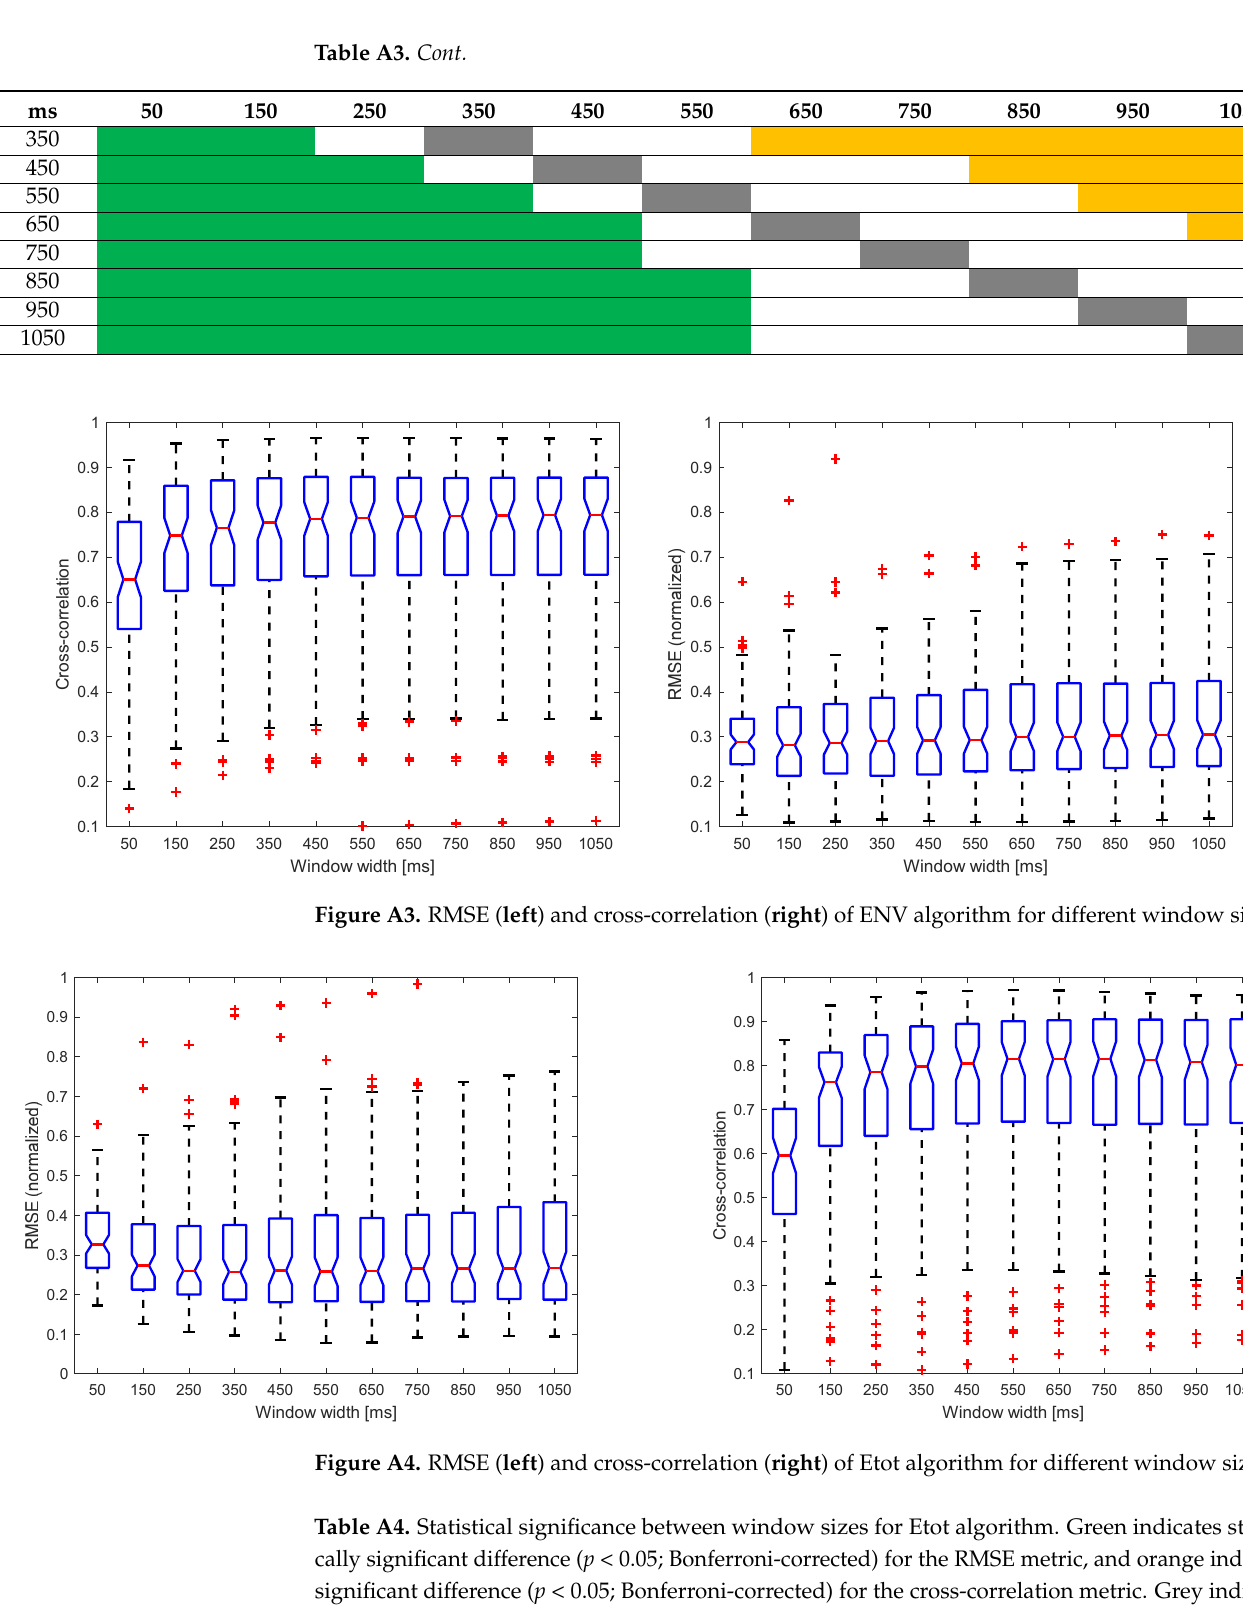
20 of 28 Figure A2. RMSE ( left ) and cross-correlation ( right ) of WL algorithm for different window sizes. Table A2. Statistical significance between window sizes for WL algorithm. Green indicates statisti-